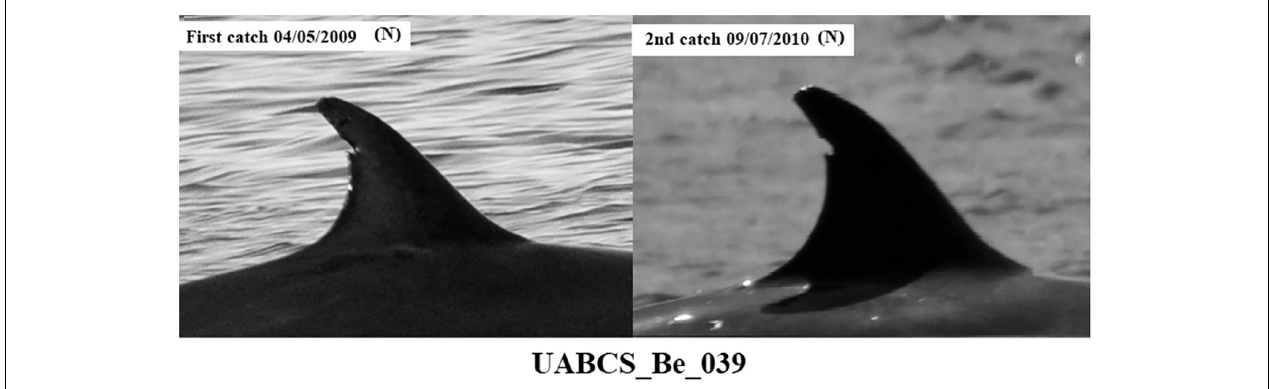
FIGURE 9 | Photographs of Bryde’s whale individual with catalog ID 039, first (2009) and second (2010) catch in the Northern Gulf of California,